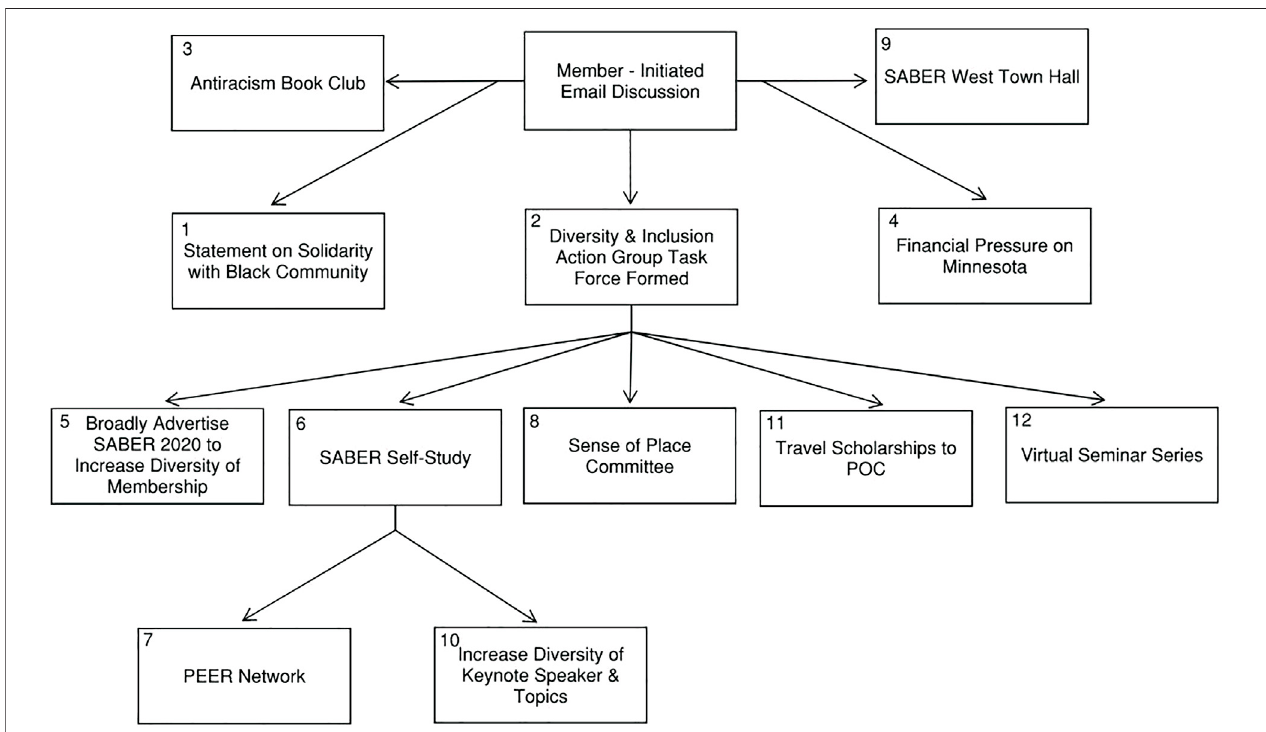
FIGURE2| ActionstakenbySABERtoincreaseinclusion.Actionsarenumberedaccordingtotheorderinwhichtheyappearinthetext.Thearrowsindicatewhich actions led to other